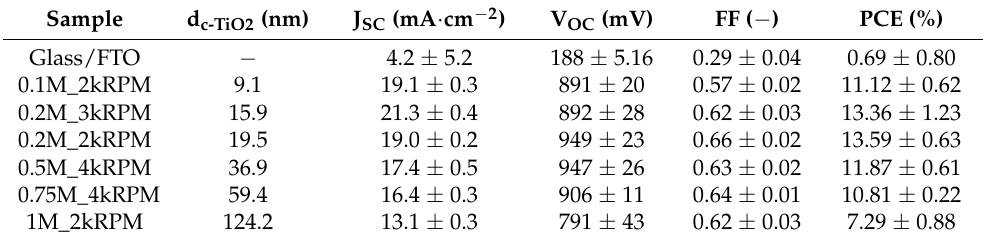
the TTDB molar concentration and centrifugation